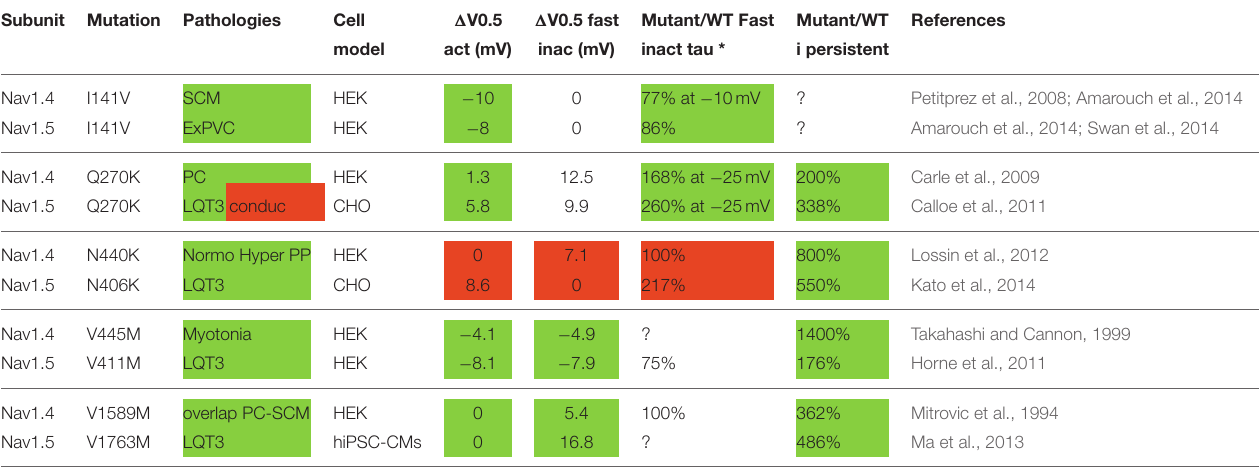
TABLE 6 | Variations of biophysical parameters compared to wild type channels for five equivalent mutations identified in Nav1.4 and Nav1.5 that have been studied extensively in patch clamp. Subunit Mutation